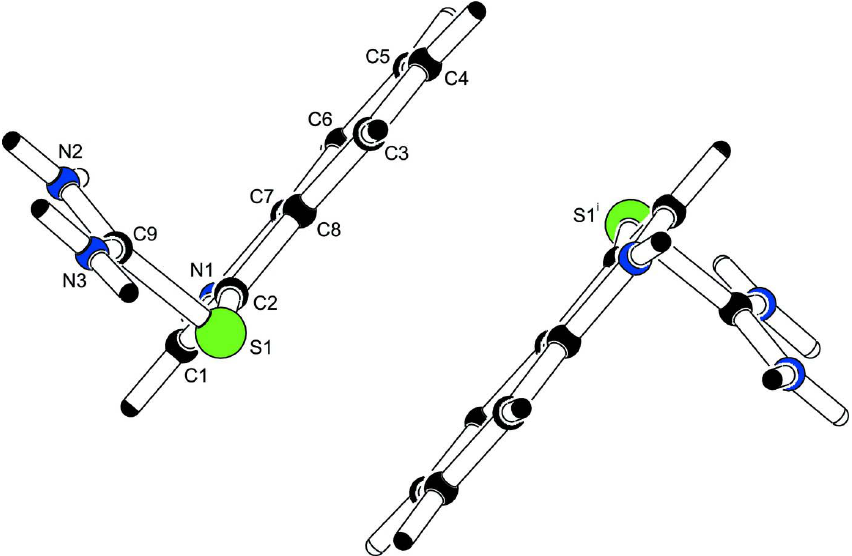
Figure 3 π stacking interactions between the indole ring systems in (I). View along the crystallographic a axis. Symmetry operation i: 1 - x , 1 - y , - z